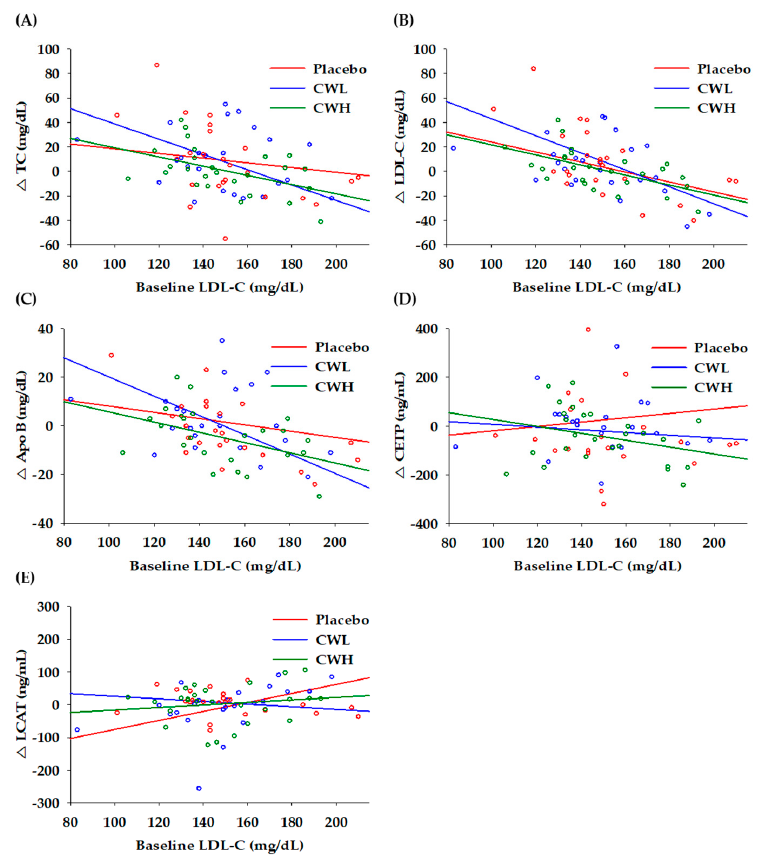
Figure 2. Correlation of cholesterol markers after 8 weeks from baseline LDL-C. ( A ) changes in total cholesterol; ( B ) changes in low density lipoprotein cholesterol; ( C ) changes in apolipoprotein B; ( D ) changes in cholesteryl ester transfer protein; and ( E ) changes in lecithin cholesterol acyltransferase.